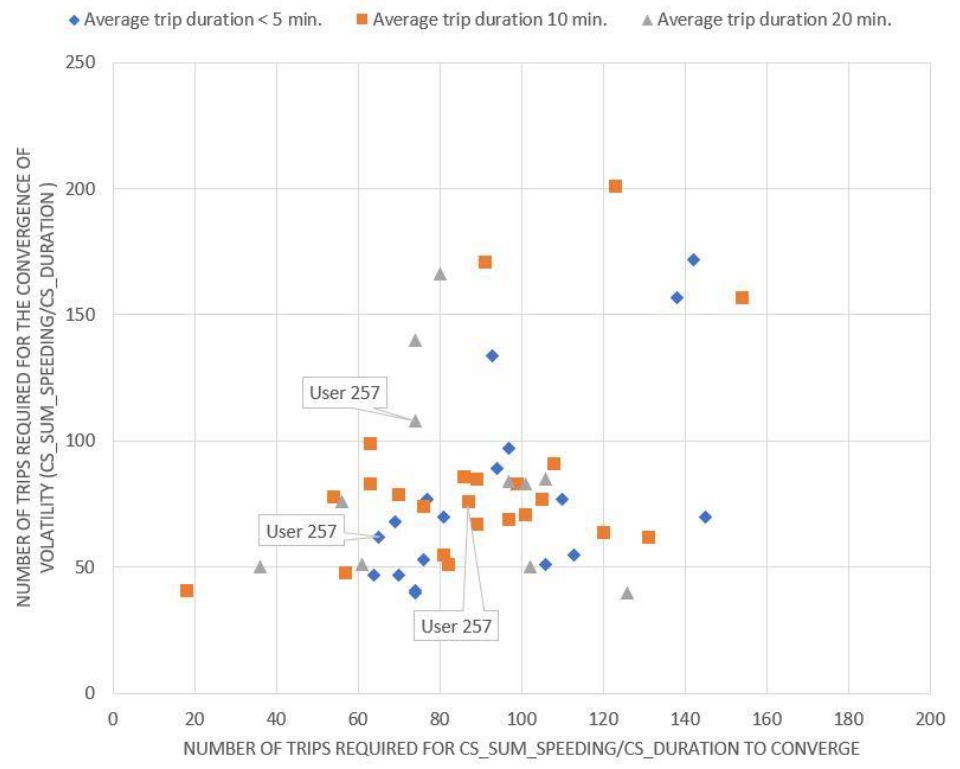
Figure 4. Minimum number of trips required for the percentage of time speeding rate to converge.